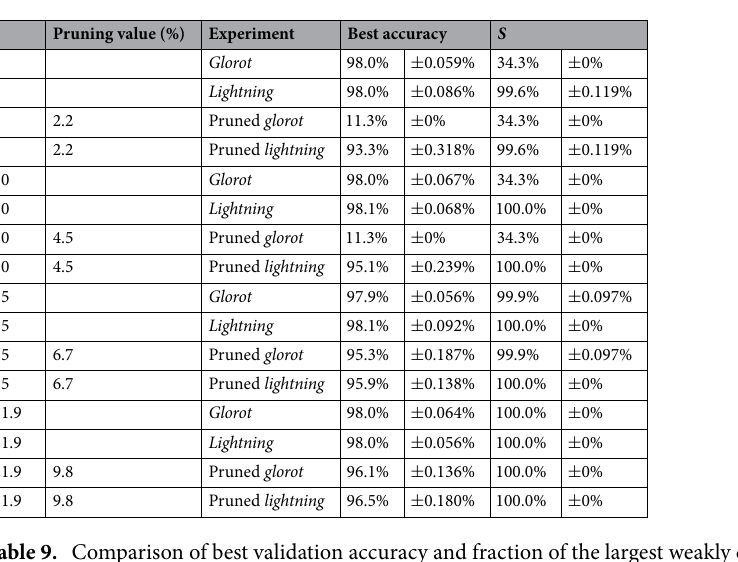
Table 9. Comparison of best validation accuracy and fraction of the largest weakly connected component S for glorot and lightning initialization for LeNet 300-100 with different mean degree c . ±-values show standard deviation over ten independent random